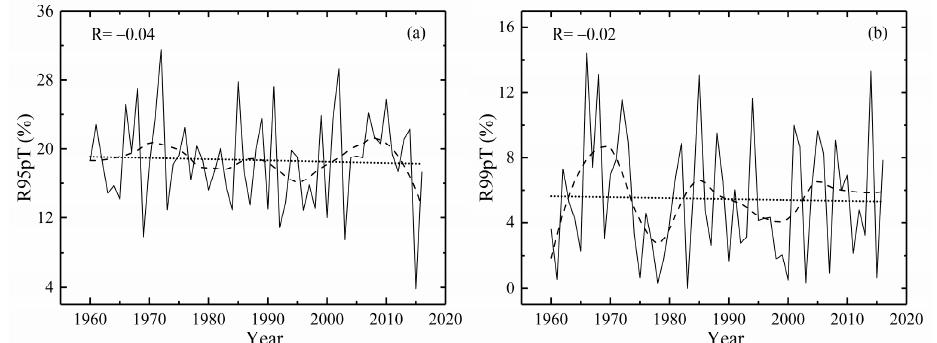
Figure 6. Regionally averaged series for ( a ) the ratio of the index of precipitation on very wet days to annual total precipitation (R95pT) and ( b ) the ratio of the index of precipitation on extremely wet days to annual total precipitation (R99pT) over the SRYR during 1960–2016. The dotted line represents the linear trend and R is its correlation coefficient. The dashed line results from LOESS smoothing.